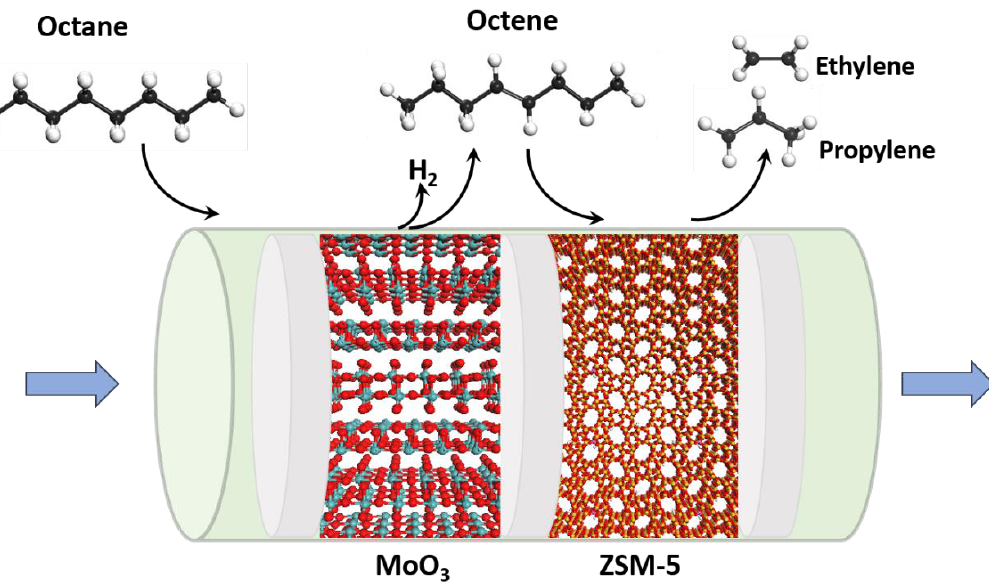
Figure 5. Proposed reaction path comprising dehydrogenation and cracking reactions in a double- bed catalyst system. catalyst